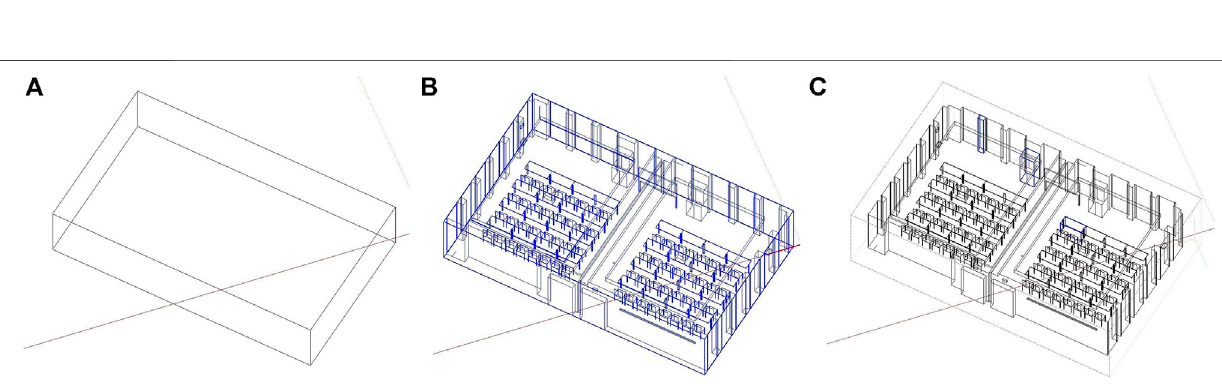
Frontiers in Built Environment |